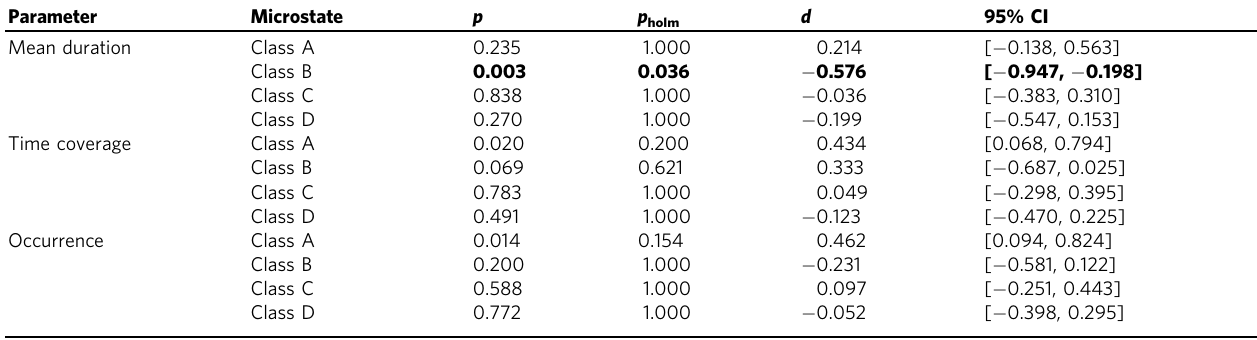
Table 3 Patients_32 vs. Siblings_32 for all microstate parameters and for each microstate